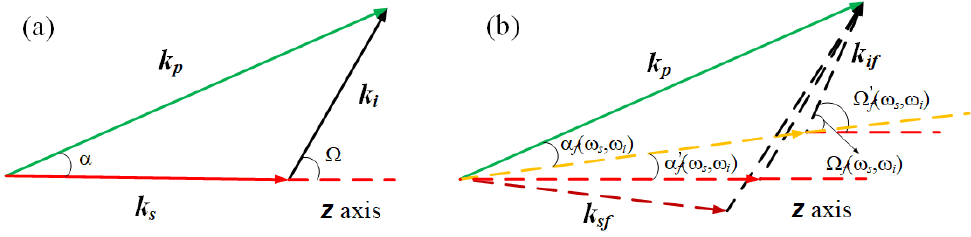
Figure 1. ( a ) Phase-matching geometry of signal and ( b ) PSF. Signal can only be phase matched perfectly at the specific wavelength due to the fixed α . Fluorescence represented by the dashed line could have the feature of angular dispersion to meet the perfect phase-matching condition. We assume that the signal propagates along the z axis, and only fluorescence in the diffraction limit of signal is